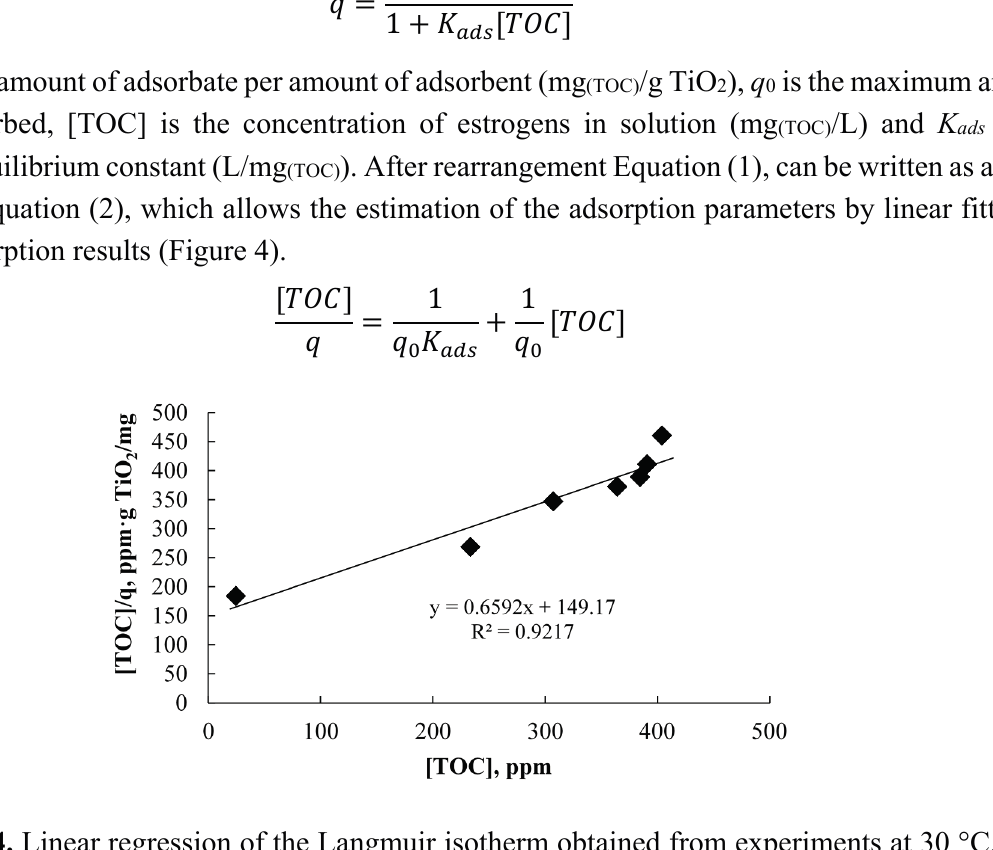
Figure 4. Linear regression of the Langmuir isotherm obtained from experiments at 30 °C, pH 6.9 and with 0.6 g/L of catalyst